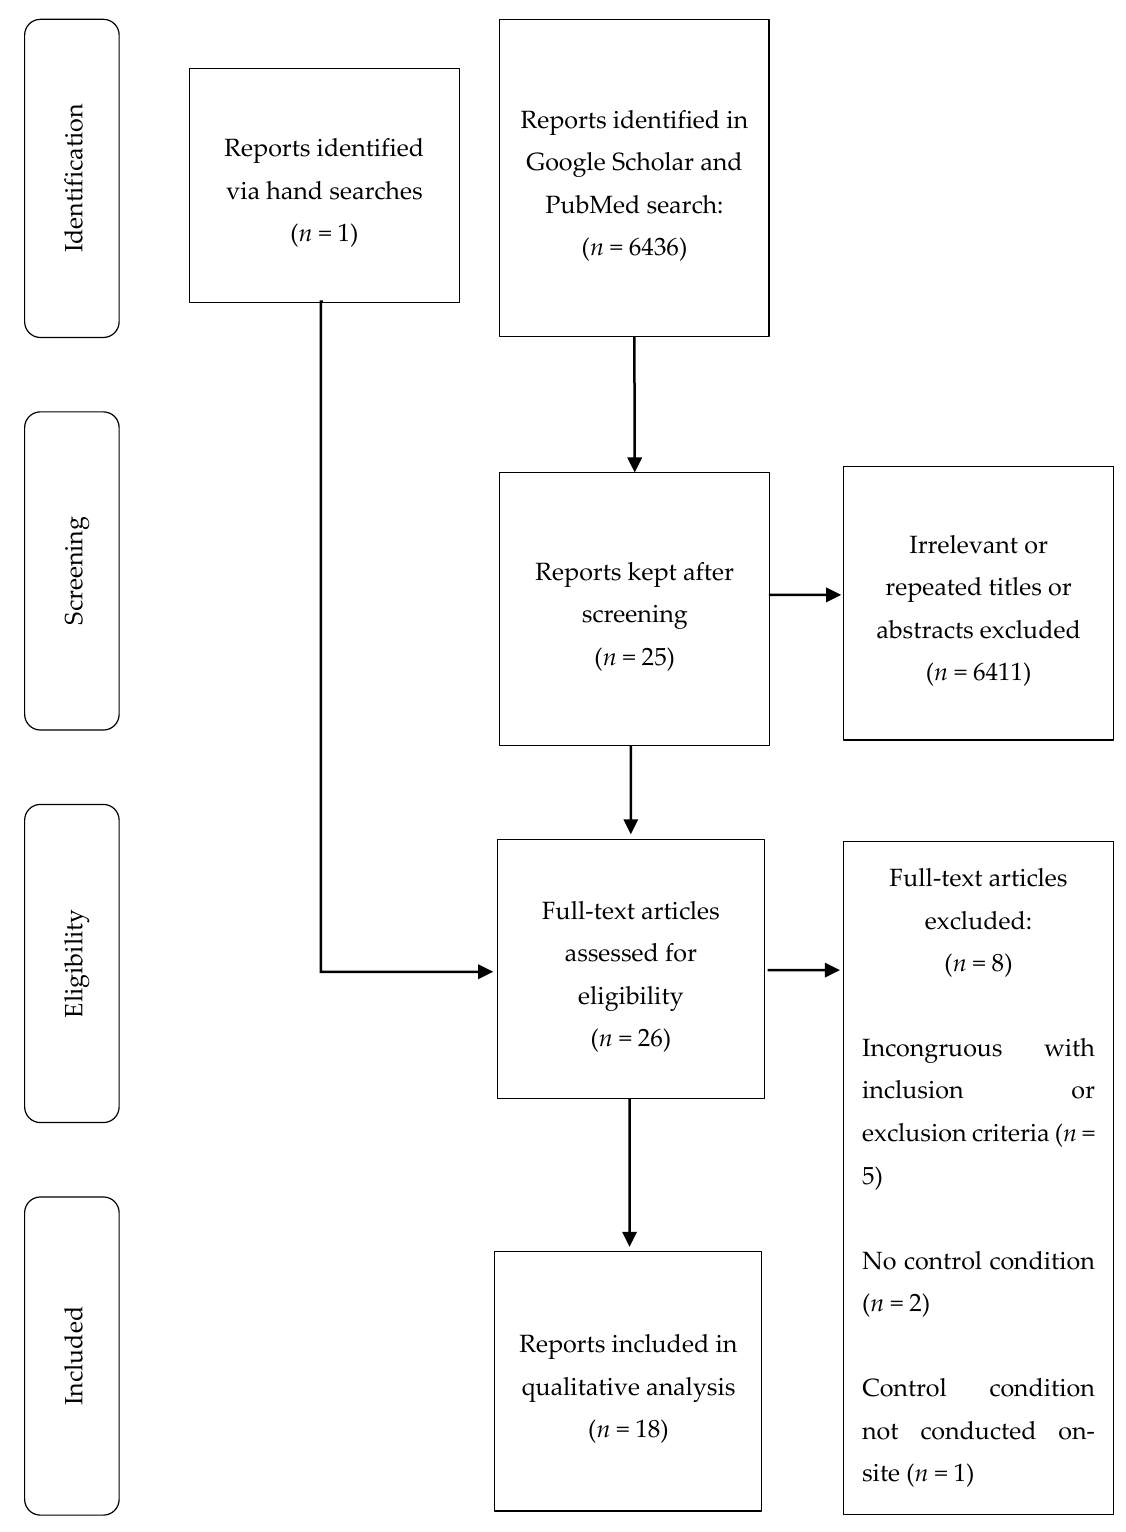
Figure 1. Flow diagram depicting the process of reviewing reports for inclusion.